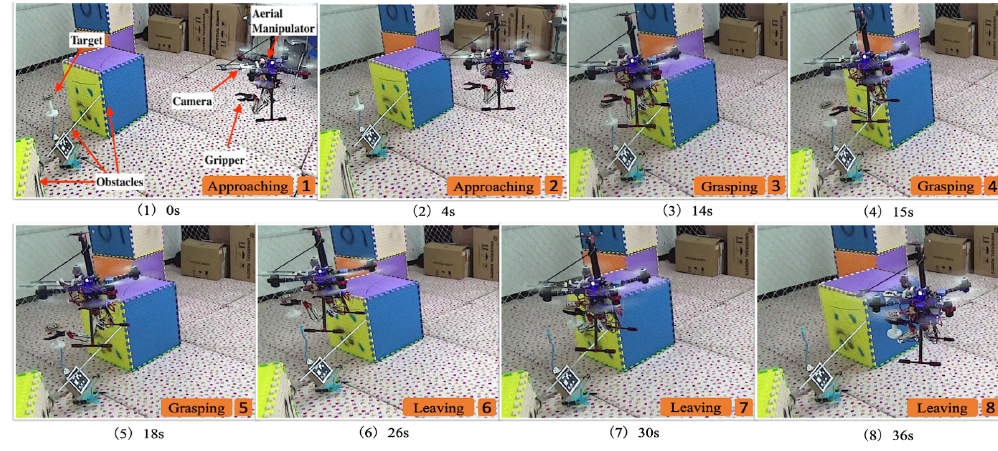
Figure 8. Snapshots of the aerial